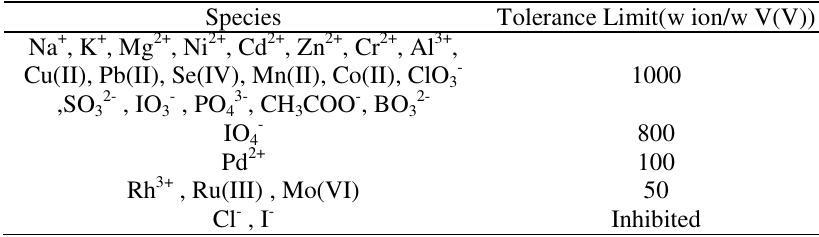
Table 2. Effect of foreign ions on the determination of 100 ng/mL V(V) Species Tolerance Limit(w ion/w